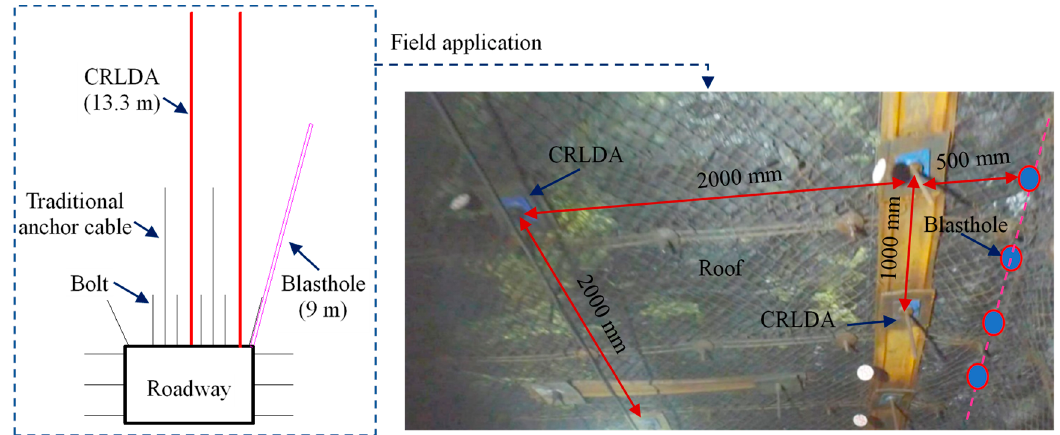
Figure 11. Design of CRLDA support in the Dianping coal mine.